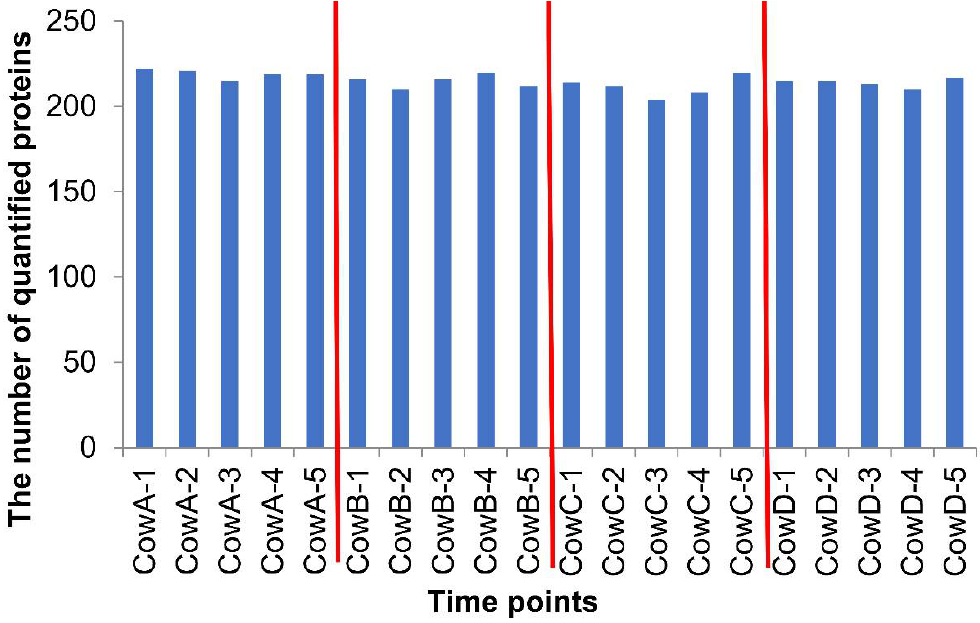
Figure 2. Number of quantified milk serum proteins in Sample Set 1 (four cows (A–D), five time points (1–5, being Day 0, Day 14, Month 1, Month 2 and Month 3, label free proteomics). points (1–5, being Day 0, Day 14, Month 1, Month 2 and Month 3, label free